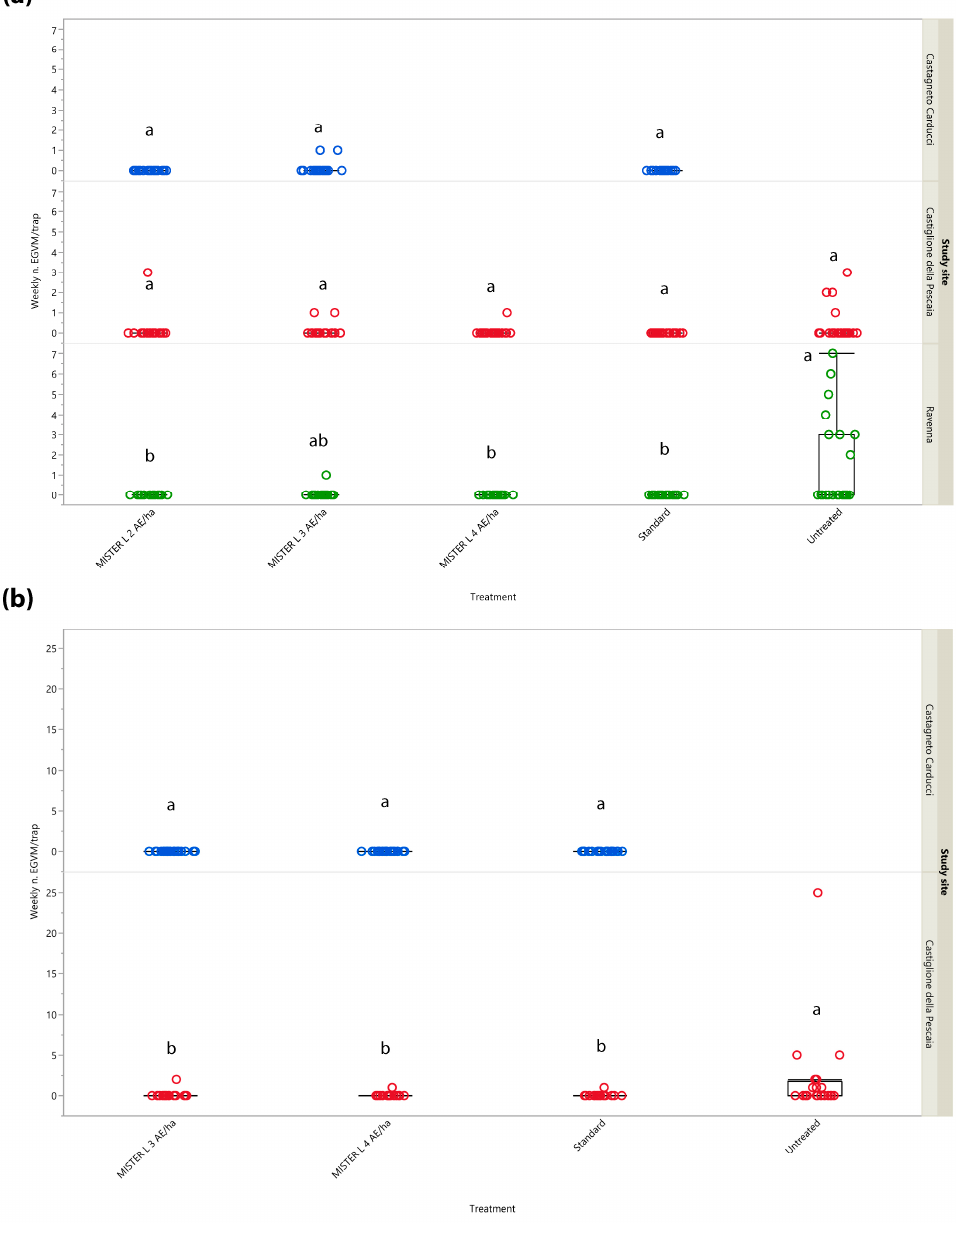
Figure 1. Box plots show weekly Lobesia botrana male catches in mating disruption treatments and standard and untreated plots in Emilia-Romagna (Northern Italy, in green) and Tuscany (Central Italy, in blue and red) in 2017 ( a ) and in Tuscany in 2018 ( b ). AE = aerosol emitters. Box plots indicate the median (solid line) within each box and the range of dispersion (lower and upper quartiles and outliers) of the male catches. Different letters above box plots indicate significant differences